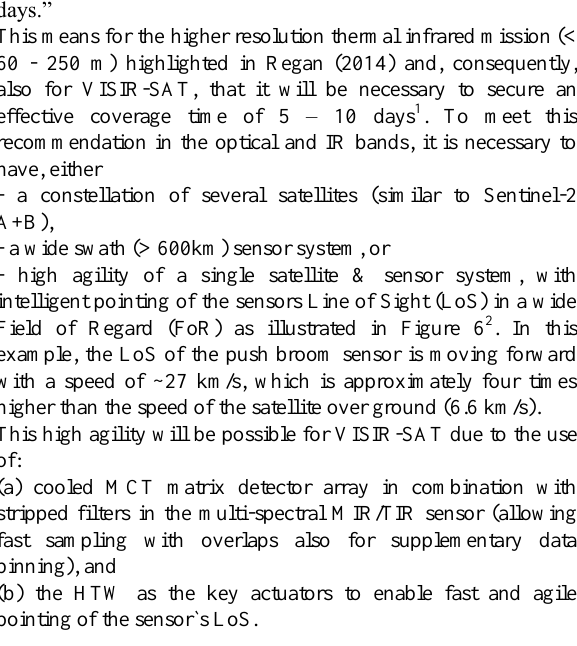
Table 2: Preliminary physical parameters of the VISIR-Sat sensor instruments Parameter